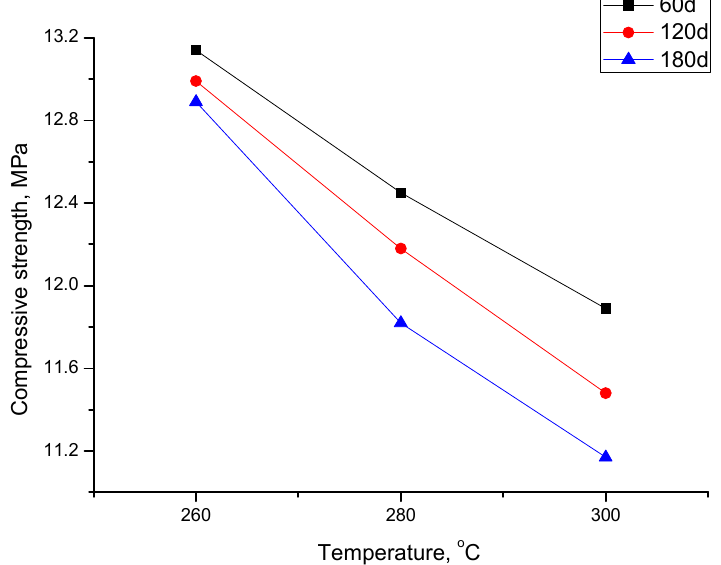
Figure 9. Compressive strength of HTP at different time and temperature levels.